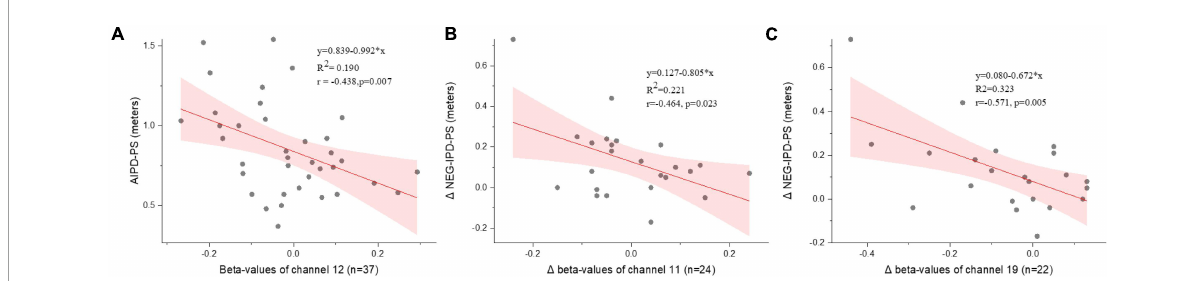
FIGURE7 Correlation between IPD performance and beta values of Oxy-Hb changes in the IPD-inclusion stage and IPD-Affection stage. (A) A significant correlation between changes of Oxy-Hb in channel 12 and the AIPD during the evaluation period in the PS condition. (B,C) A significant correlation between (cid:49) beta-values of Oxy-Hb changes in channels 11 and 19 and the (cid:49) NEG-IPD during the action period in the PS condition. PS, peer social status; AIPD, active interpersonal distance; (cid:49) NEG-IPD, IPD gaps in IPD after negative feedback minus the baseline; Each scatter plot reports the equation formula (y = b + a ∗ x), regression square of fitted linear regression ( R 2 ), Pearson correlation coefficients (r), p -values, 95% confidence interval (pink shadow) and one piece of dyad data (gray